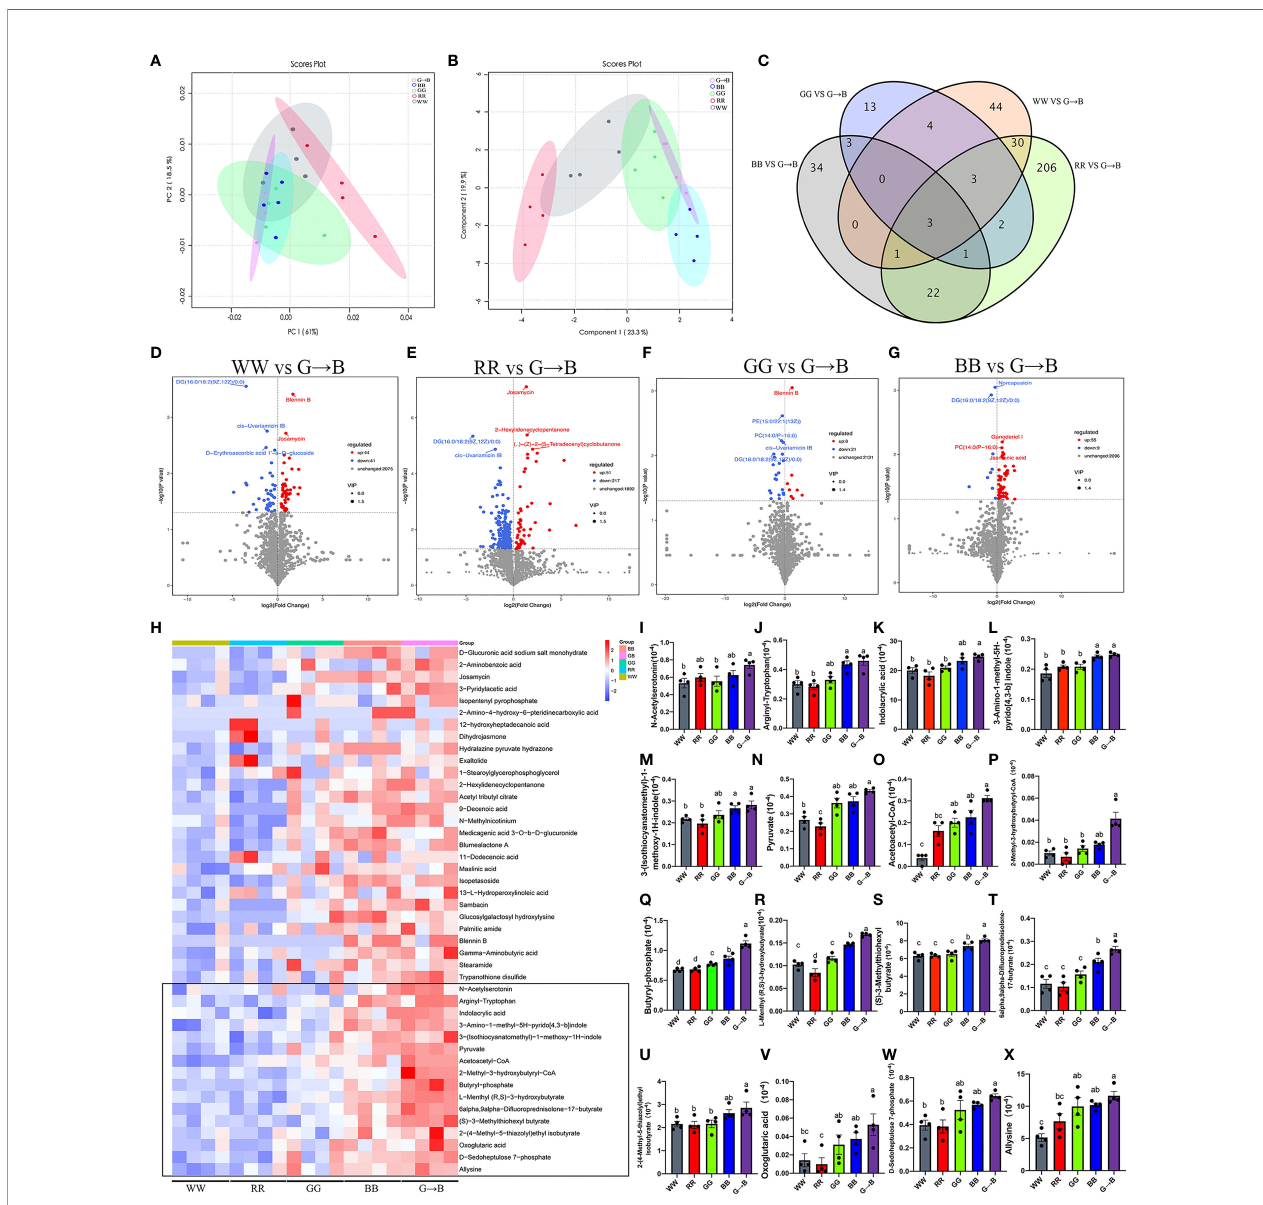
FIGURE 6 | The b -diversity of the principal component analysis (A) and partial least squares discriminant analysis based on the microbiota metabolites (B) in the WW, RR, GG, BB, and G ! B groups at P42. Venn diagram based on the microbiota metabolites (C) in the WW, RR, GG, BB, and G ! B groups. Volcano plot based on the differential metabolite screening compared with the WW and G ! B groups (D) . Volcano plot based on the differential metabolite screening compared with the RR and G ! B groups (E) . Volcano plot based on the differential metabolite screening compared with the GG and G ! B groups (F) . Volcano plot based on the differential metabolite screening compared with the BB and G ! B groups (G) . Heat map of the redundancy analysis ‐ identi fi ed 49 key metabolites that were signi fi cantly altered in the chick cecum microbe of G ! B group at P42 (H) . The relative abundance of N-acetyserotomimin (I) , arginyl-tryptophan (J) , indolacrylic acid (K) , 3-amino-1-methyl-5H-pyrido[4,3-b]indole (L) , 3-(isothiocyanatomethyl)-1-methoxy-1H-indole (M) , pyruvate (N) , acetoacetyl-CoA (O) , 2-methyl-3-hydroxybutyryl- CoA (P) , butyryl-phosphate (Q) , L-menthyl (R,S)-3-hydroxybutyrate (R) , (S)-3-methylthiohexyl butyrate (S) , 6alpha,9alpha-di fl uoroprednisolone-17-butyrate (T) , 2-(4- methyl-5-thiazolyl)ethyl isobutyrate (U) , oxoglutaric acid (V) , D-sedoheptulose 7-phosphate (W) , and allysine (X) in the WW, RR, GG, BB, and G ! B groups at P42 in the cecum microbiota based on the heat map results. WW, white light; RR, red light; GG, green light; BB, blue light; G ! B, green light and blue light combination. The results are presented as means ± SEM. Different letters indicate signi fi cant differences between the treatments at the same age ( P <